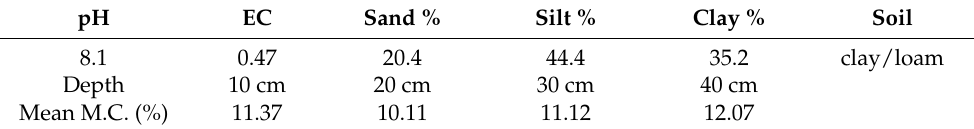
Table 1. Soil characteristics and the mean of soil moisture content (%) at different depths.